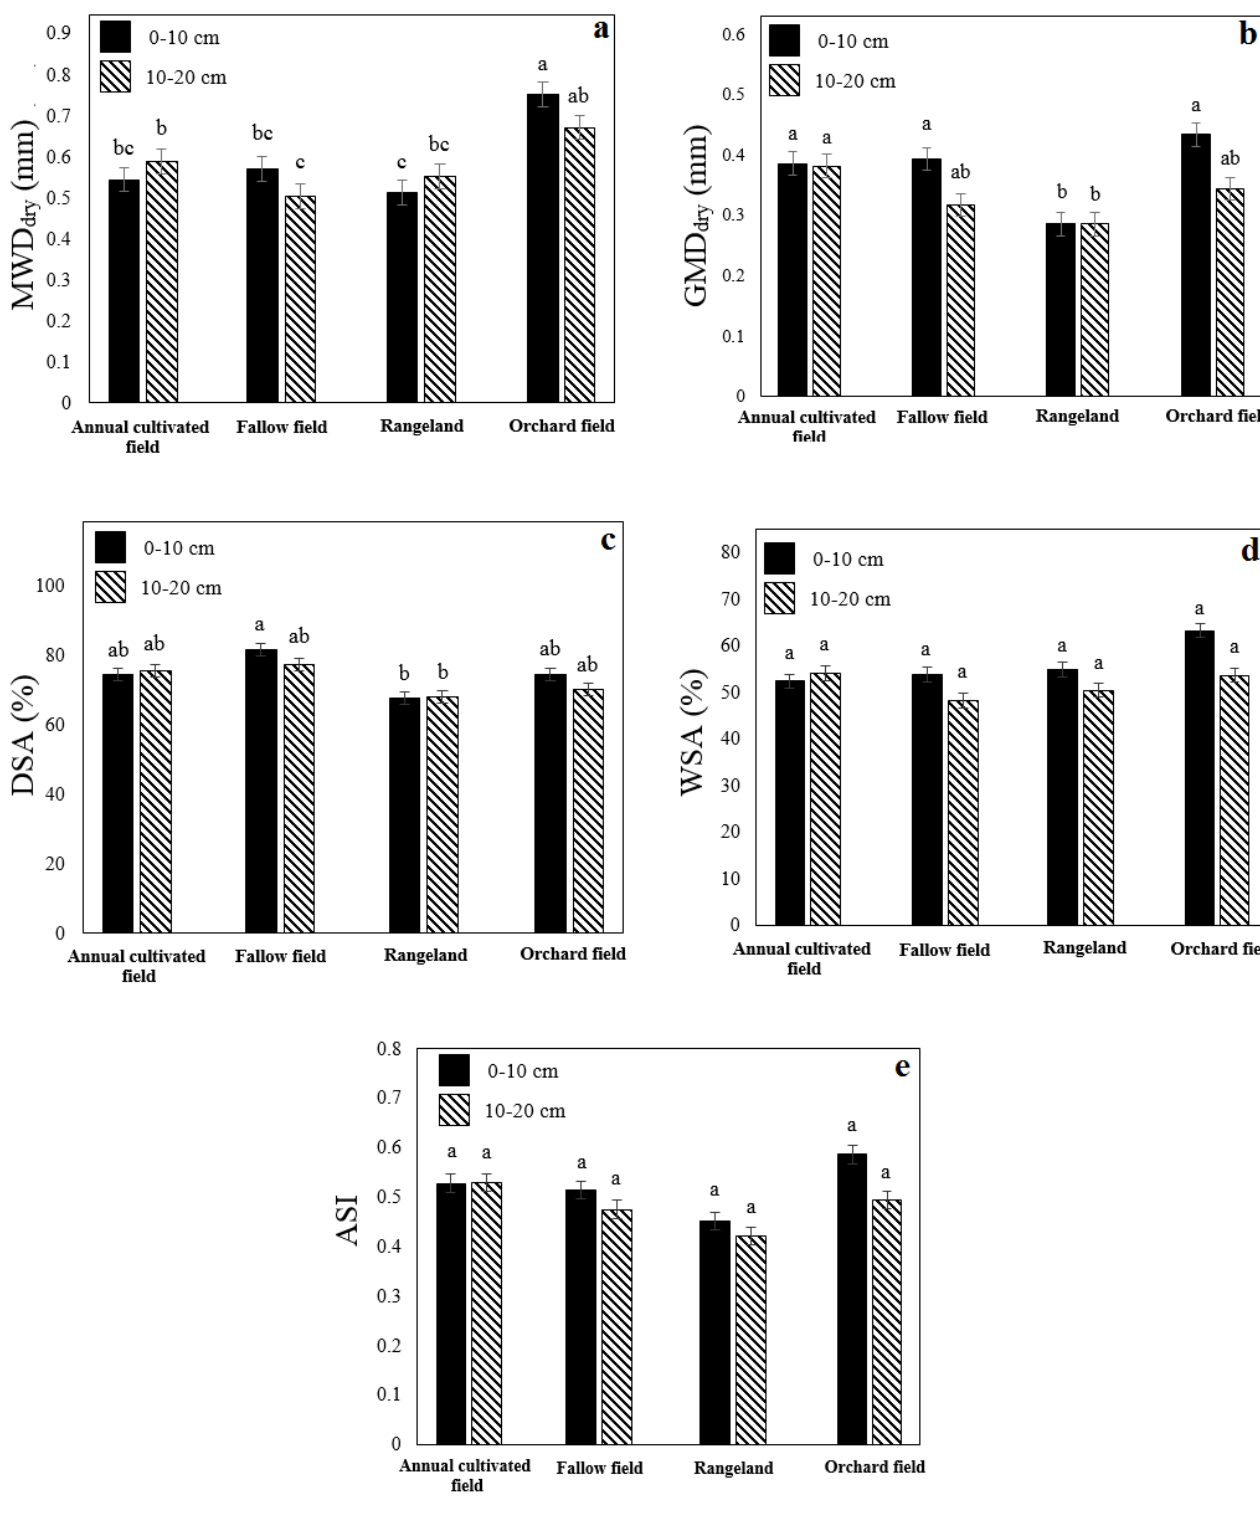
Figure 2. Mean comparison of MWD dry ( a ), GMD dry ( b ), DSA ( c ), WSA ( d ), and ASI ( e ) indices in studied land-use types and soil depths. Vertical bars represent standard deviations of the means. Values followed by different letters are significantly different ( p < 0.05).